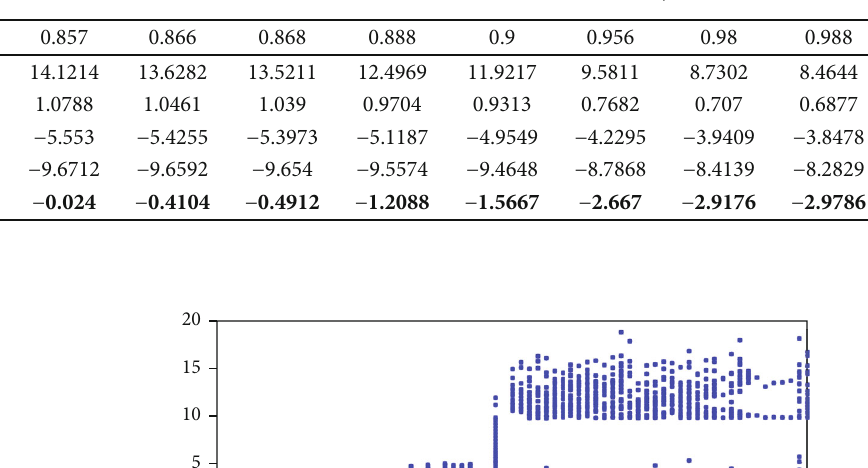
Table 1: LEs for di ff erent fractional orders η .